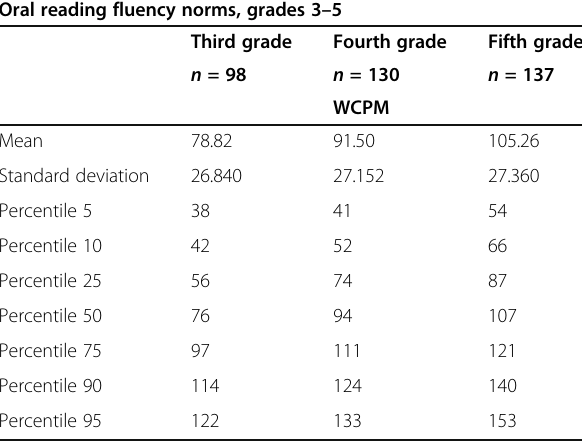
Table 1 Distribution of means, standard deviation and WCPM percentiles for readings of the passage entitled “ The Umbrella ”